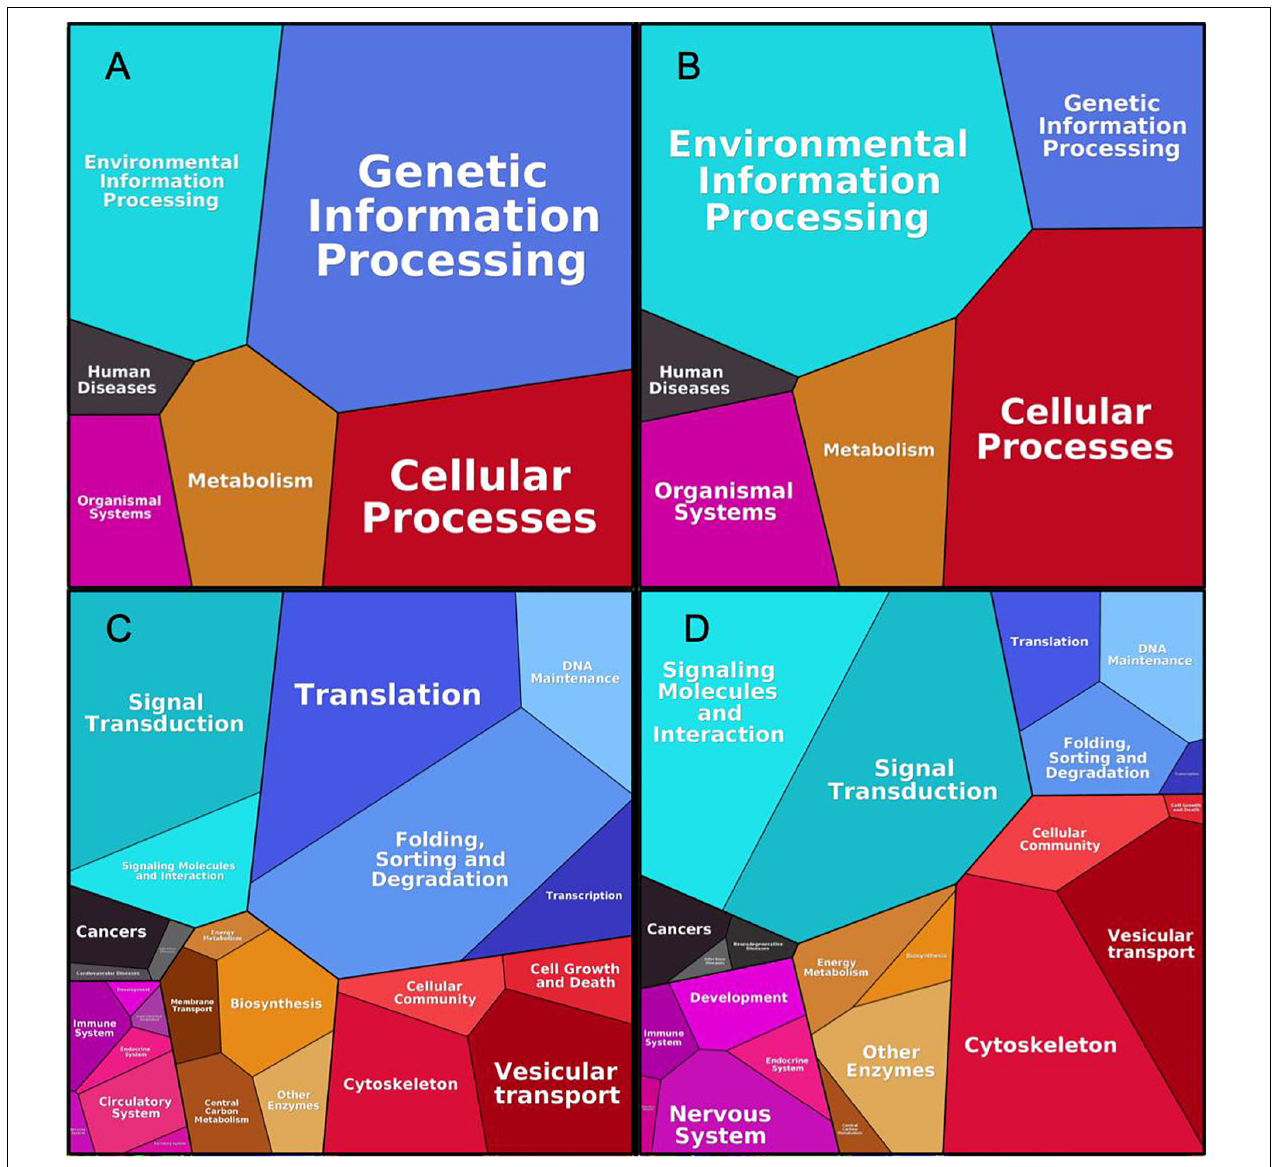
FIGURE 6 | Proteomaps for cancer and synaptic sets. As shown in Liebermeister et al. (2014), upper figures correspond to high-level KEGG functional division for p140Cap Cancer (A) and Synaptic (B) proteome; Bottom figures correspond to respective lower hierarchy terms for Cancer (C) and Synaptic (D) proteomes.